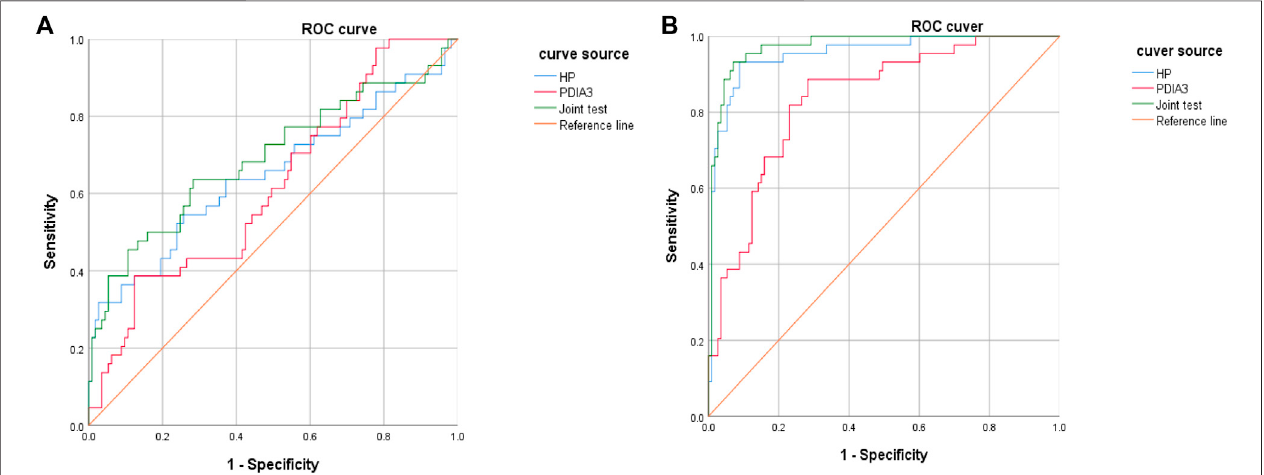
FIGURE 6 | Diagnosis value of HP and PDIA3 to early colorectal cancer and progressive stage. (A) . Low diagnosis accuracy of early colorectal cancer. (B) . Great assessment value to pathological staging of colorectal cancer.